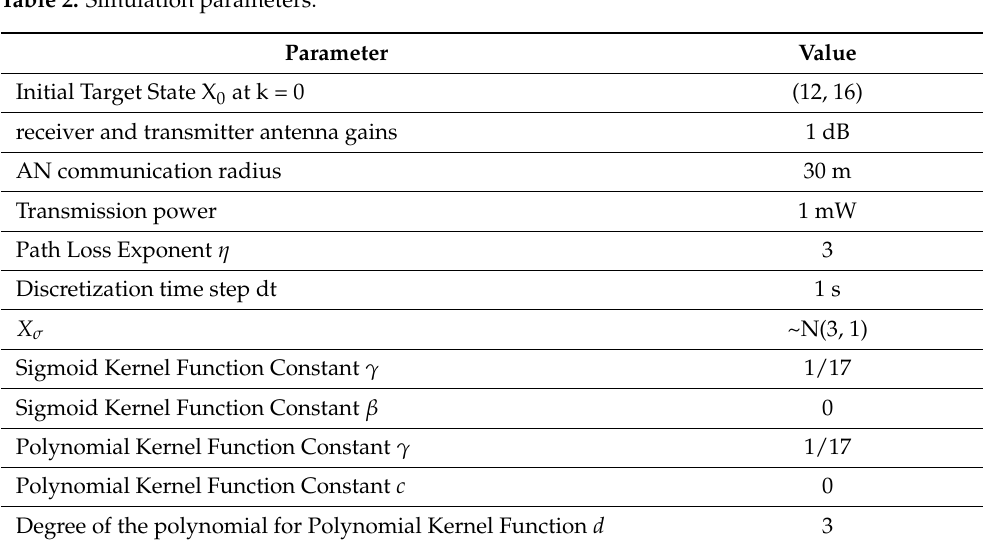
Table 2. Simulation parameters.